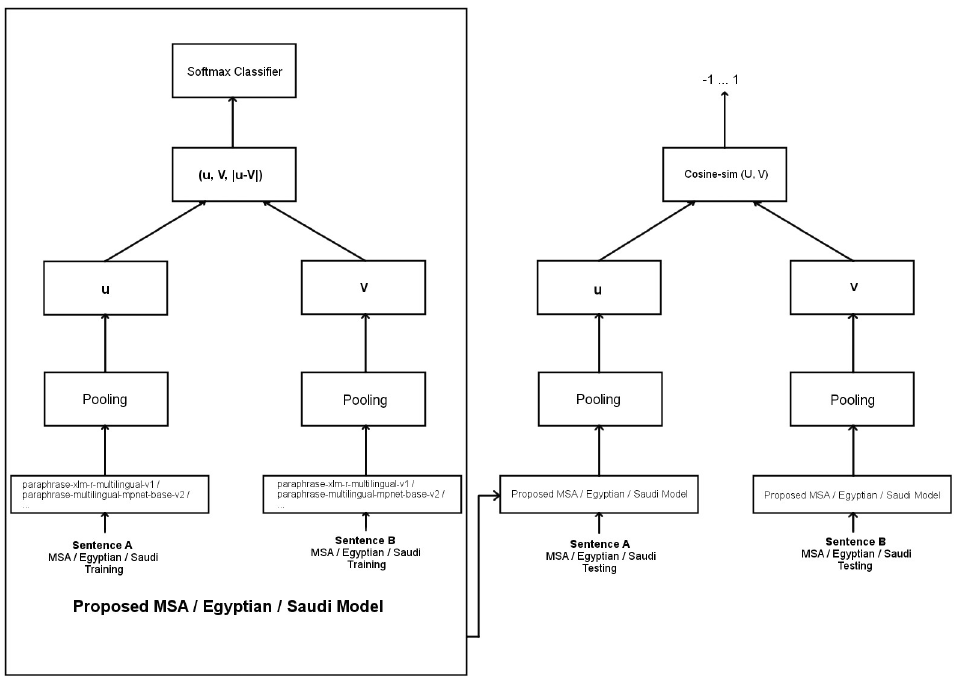
Fig 3. A framework of models generation using the third